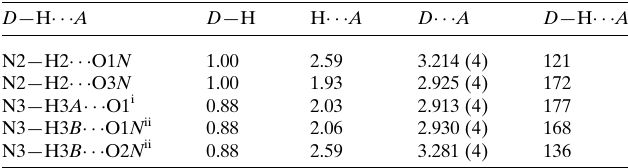
Table 1 Hydrogen-bond geometry (A˚ , (cid:5) ).